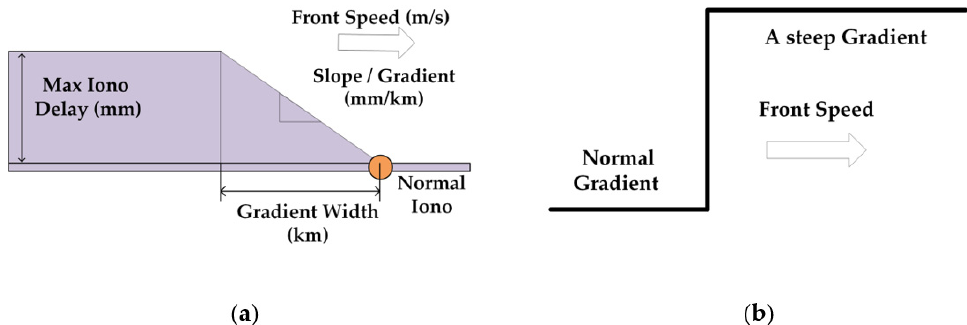
Figure 1. Illustrations of predigested ionospheric anomaly ( a ) and ionospheric gradient anomaly ( b ) models (Figure based on [3]).